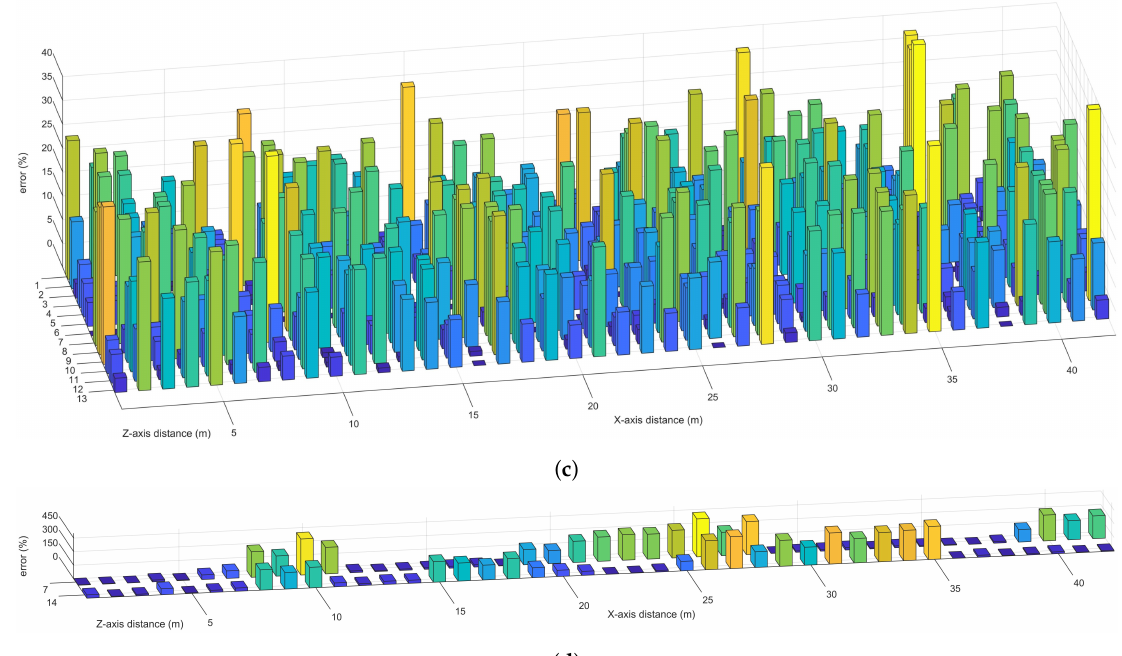
Figure 17. ( a , b ) show the predicted and experimental deposition volume per area, respectively. ( c , d ) show the prediction error calculated in accordance with Formula